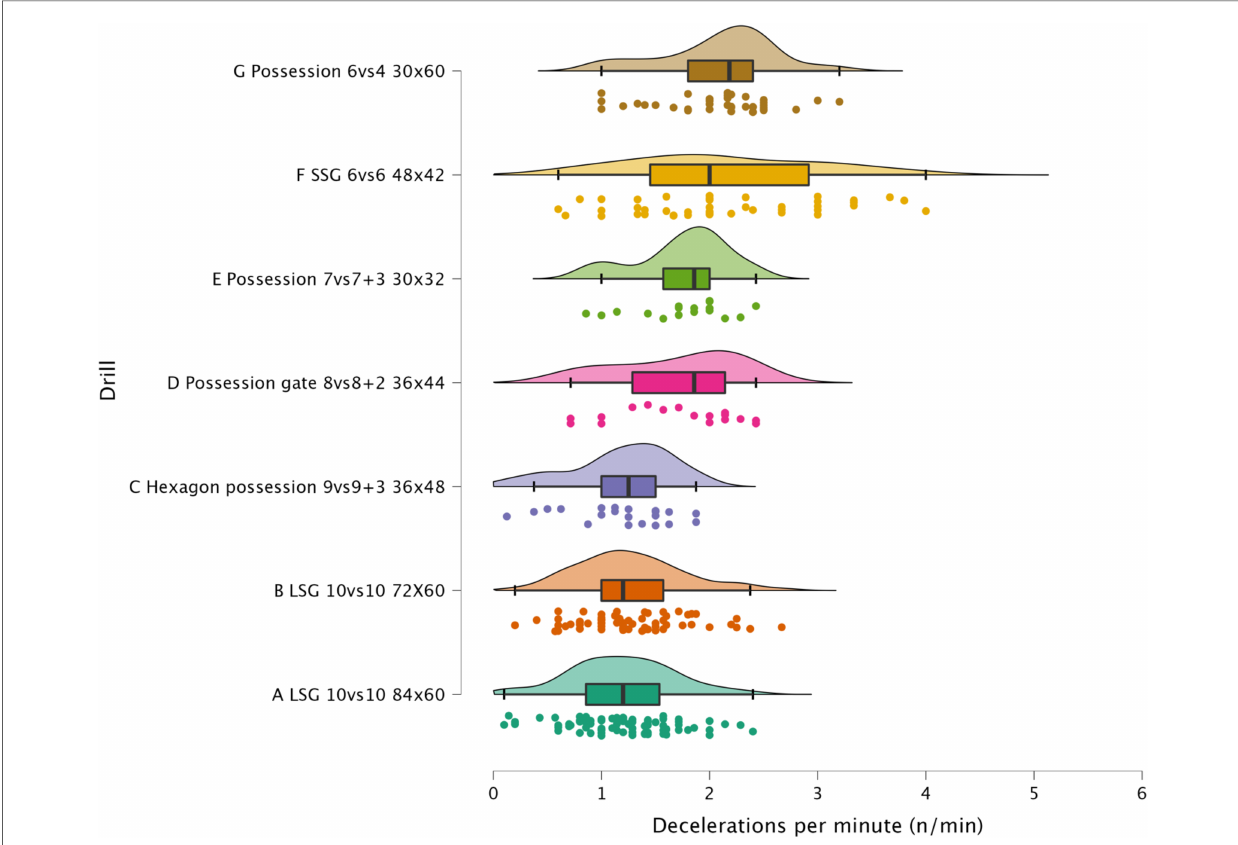
FIGURE 5 Comparison of decelerations per minute between drills. The data distributions show, mean, standard deviation, 95% con fi dence intervals, and individual data